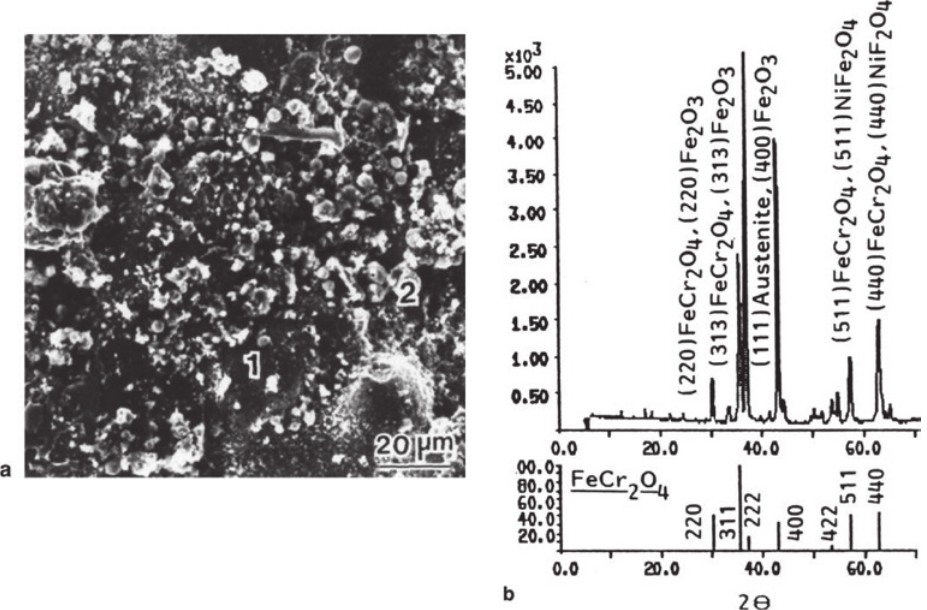
Fig. 12: (a) SEM image of scale morphology and (b) XRD pattern derived from surface scale